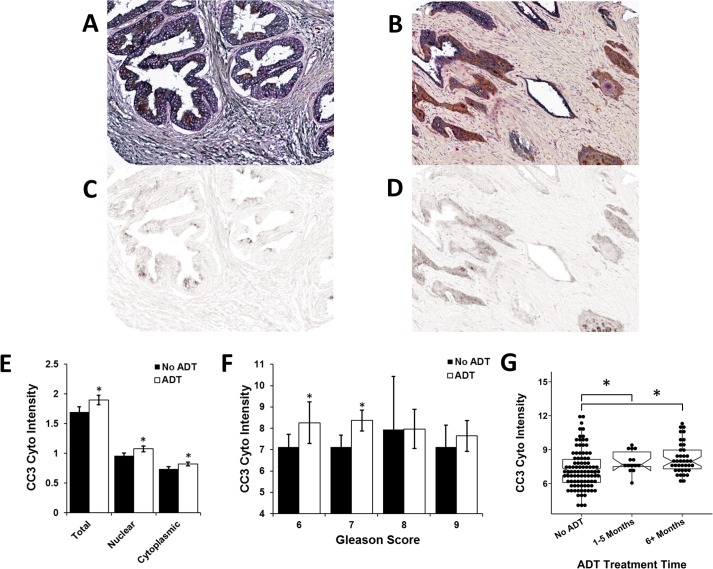
Cleaved caspase 3 (CC3) expression increases in intermediate grade cancers and occurs early after ADT.CC3 immunohistochemistry was performed on neoadjuvant ADT and control prostate tissues and then quantitated using the automated imaging analyzer VECTRA. Gleason scoring was performed on pretreatment biopsies. (A) Cell nuclear and cytoplasmic levels of CC3 demonstrate increased expression in ADT treated PCa tissues and increased levels in Gleason score 6 and 7 (B) compared to untreated controls. (C) CC3 expression is shown according to duration of neoadjuvant ADT treatment and compared to untreated controls. Significant increases in CC3 levels were seen within 1-5mo after ADT initiation. *p<0.05; mean±SE.